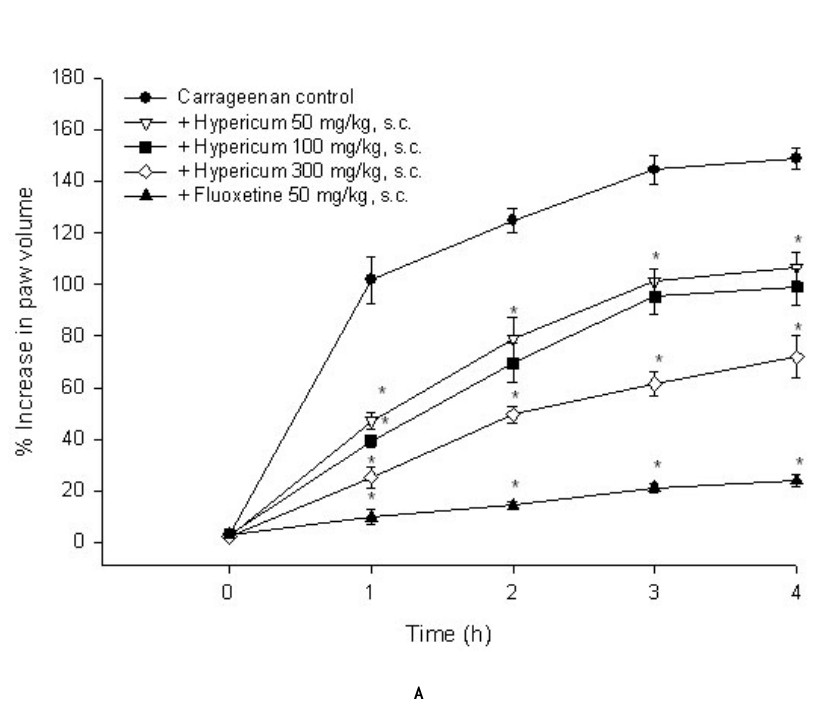
FIGURE 1. The antiedema effect of H. perforatum extract, fluoxetine (A) and etodolac (B). Results are expressed as a percentage change from control (predrug) values, each point represents mean ± S.E of 6 rats per group. Asterisks indicate significant change from control value at respective time points (ANOVA and Duncan’s multiple comparison